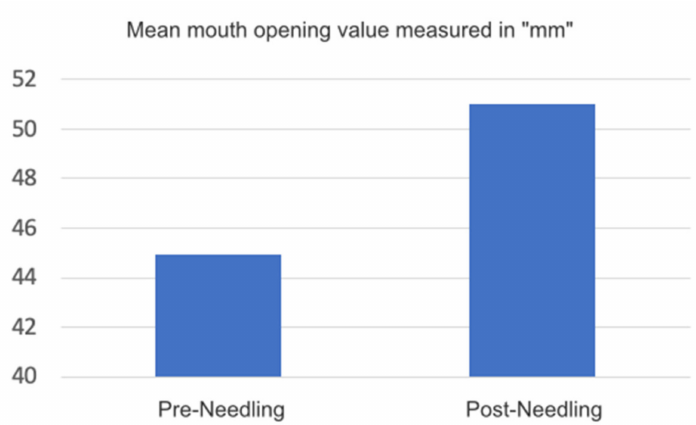
Figure 7. Graph mean mouth opening value measured in